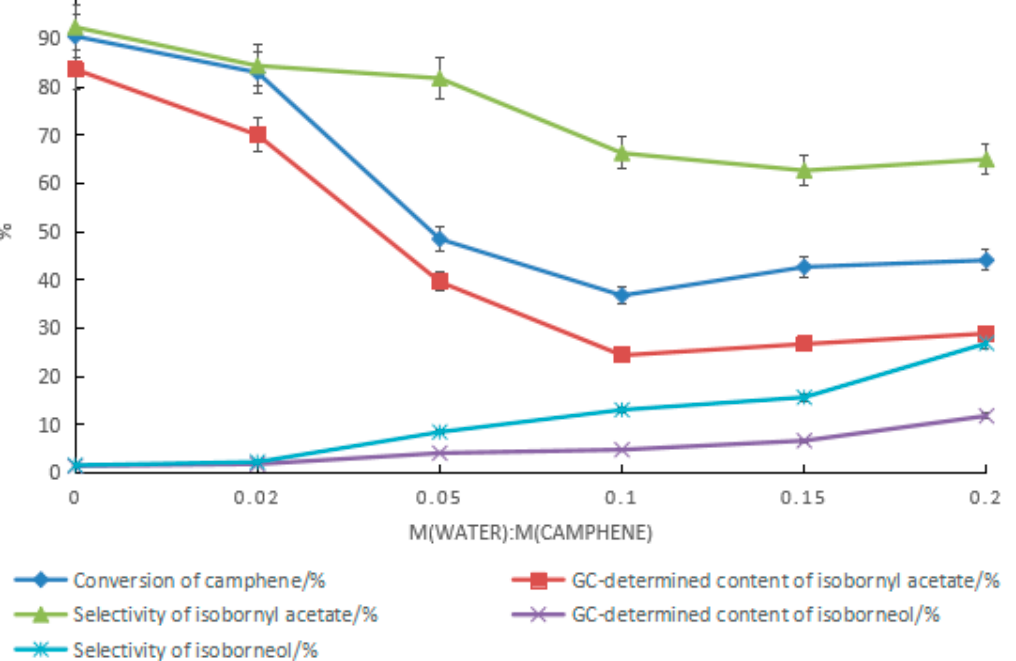
Figure 7. Effect of water on the reaction when mandelic acid–boric acid was used as the catalyst. Reaction conditions: m(camphene):m(acetic acid):m(mandelic acid):m(boric acid) = 10:25:1:0.4, reaction temperature of 70 °C, and reaction time of 18 h.